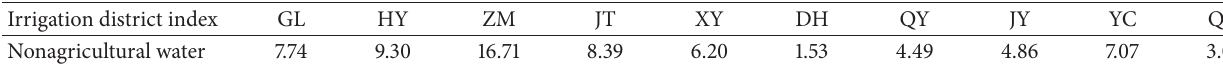
Table 4: Nonagricultural water of irrigation districts (10 6 m 3 ).